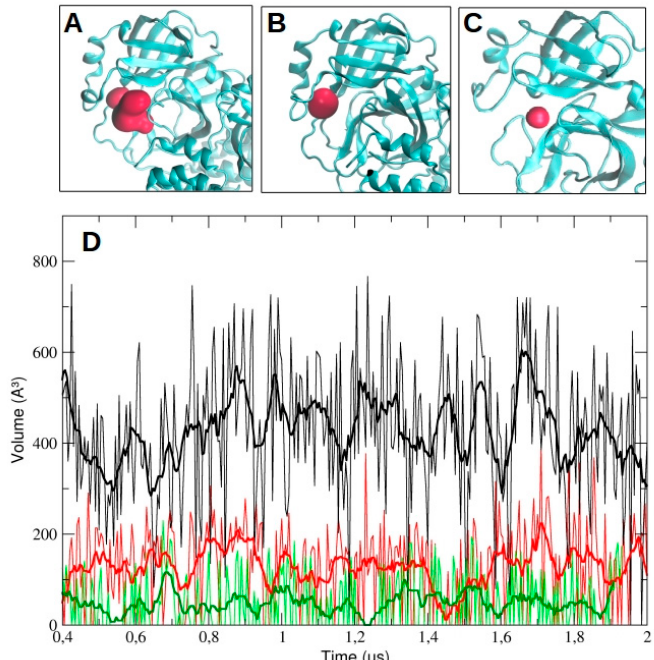
Figure 11. Pocket detection and evolution during MD simulation trajectory. The binding pocket volume was identified by MDpocket and later monitored for changes in volume. The pocket volume is represented in red surface in the dimeric 3CLpro (( A ) chain A, ( B ) chain B) and in monomeric form ( C ), represented in cyan. In ( D ), the comparison of the evolution of the volume pocket in chain A (black line) and chain B (red line) of the dimer and of the monomer (green line) is represented. The bold line is a smoothed curve of the respective changes in volume line, intended to clarify the behavior of the pocket.